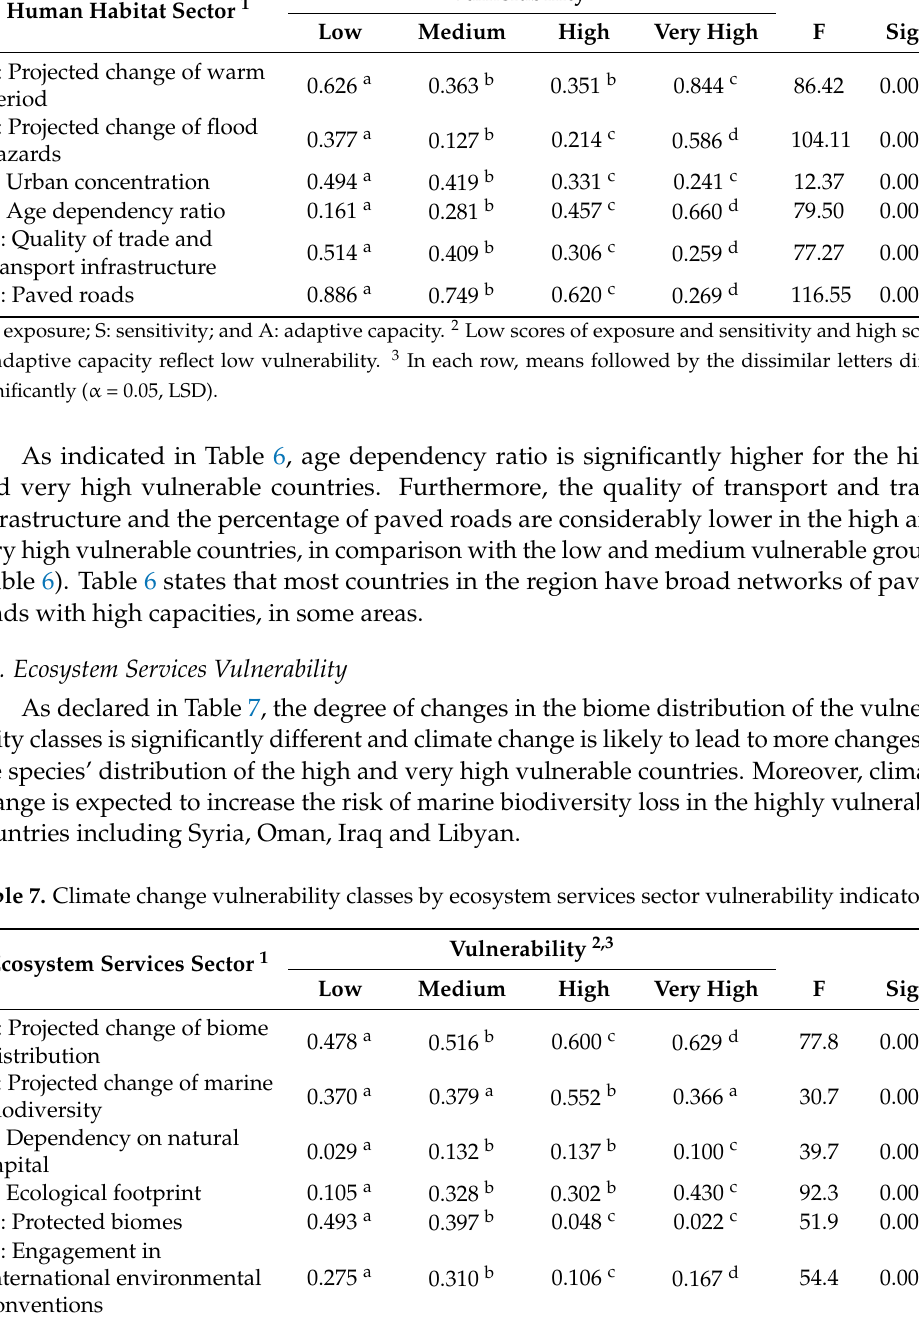
Table 6. Climate change vulnerability classes by human habitat sector vulnerability indicators. Human Habitat Sector 1